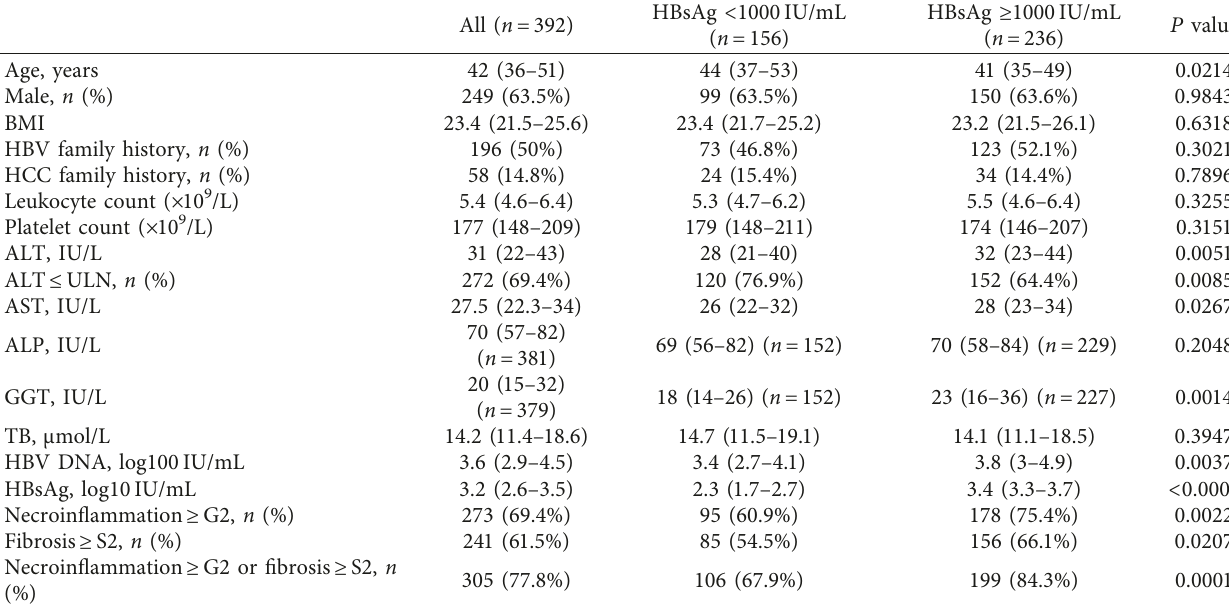
Figure 1: Patient flow diagram. Table 1: Baseline characteristics of HBeAg-negative chronic HBV infection patients based on HBsAg